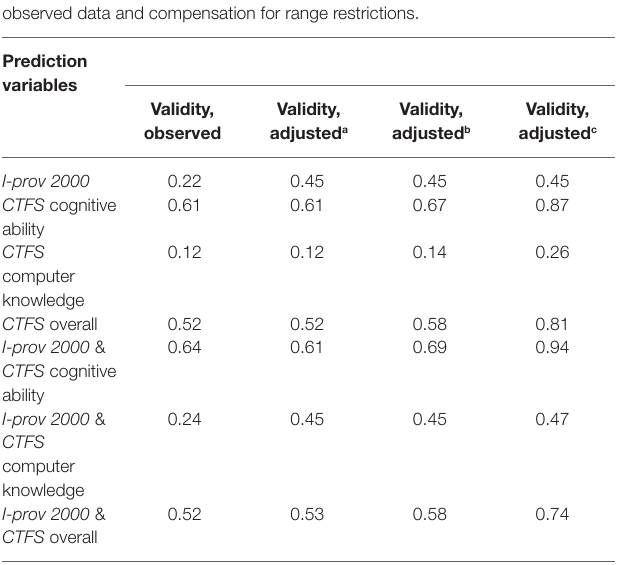
TABLE 4 | Validity of models predicting cyber soldiers’ course scores with observed data and compensation for range restrictions. Prediction